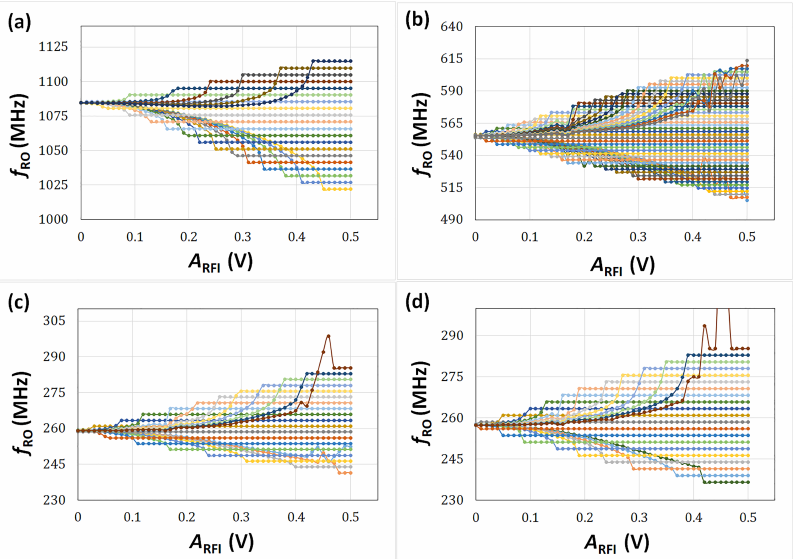
Figure 4. Conical locking regions of the 41-stage ROs under different CMOS processes. ( a ) SMIC-65 nm process; ( b ) SMIC-130 nm process; ( c ) SMIC-180 nm process; ( d ) TSMC-180 nm